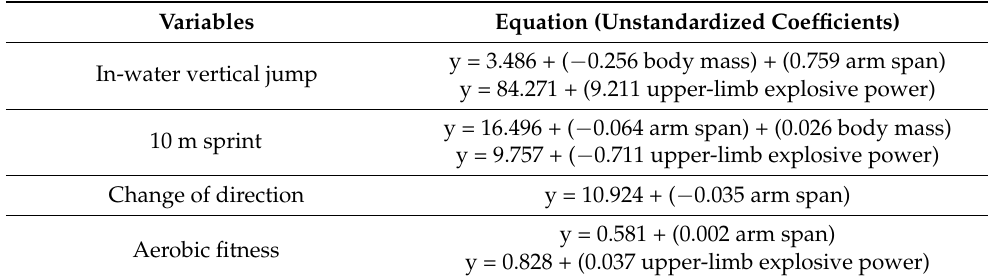
Table 4. Association of water polo players’ specific motor abilities with their anthropometric and general motor performance